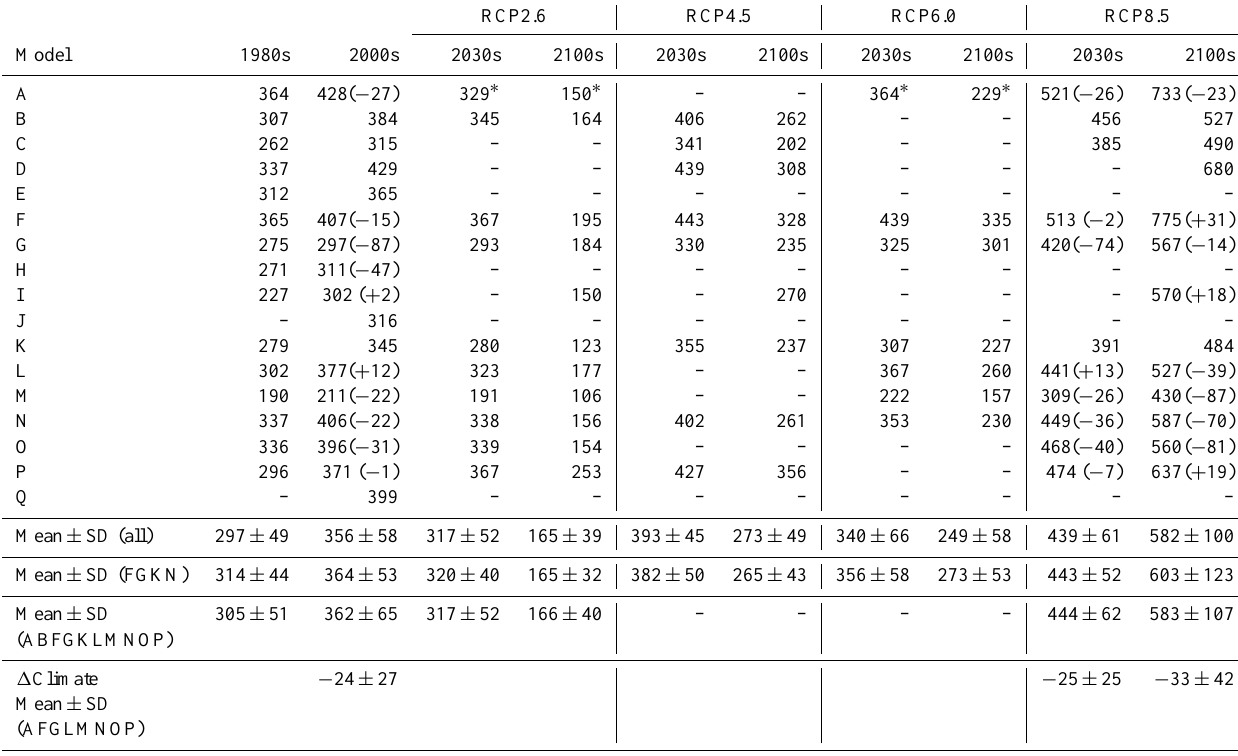
Table 12. Tropospheric ozone RFs (mW m − 2 ) relative to the 1850s (for MASKZMT), calculated from column ozone changes and normalised RFs for each model. Values shown for some models in brackets under 2000s and for the RCP8.5 scenario are the impact of climate change on RF, with mean ( ± SD) values given in the last row. NB values for 2000s differ very slightly from Table 3 due to the masking of some normalised RF